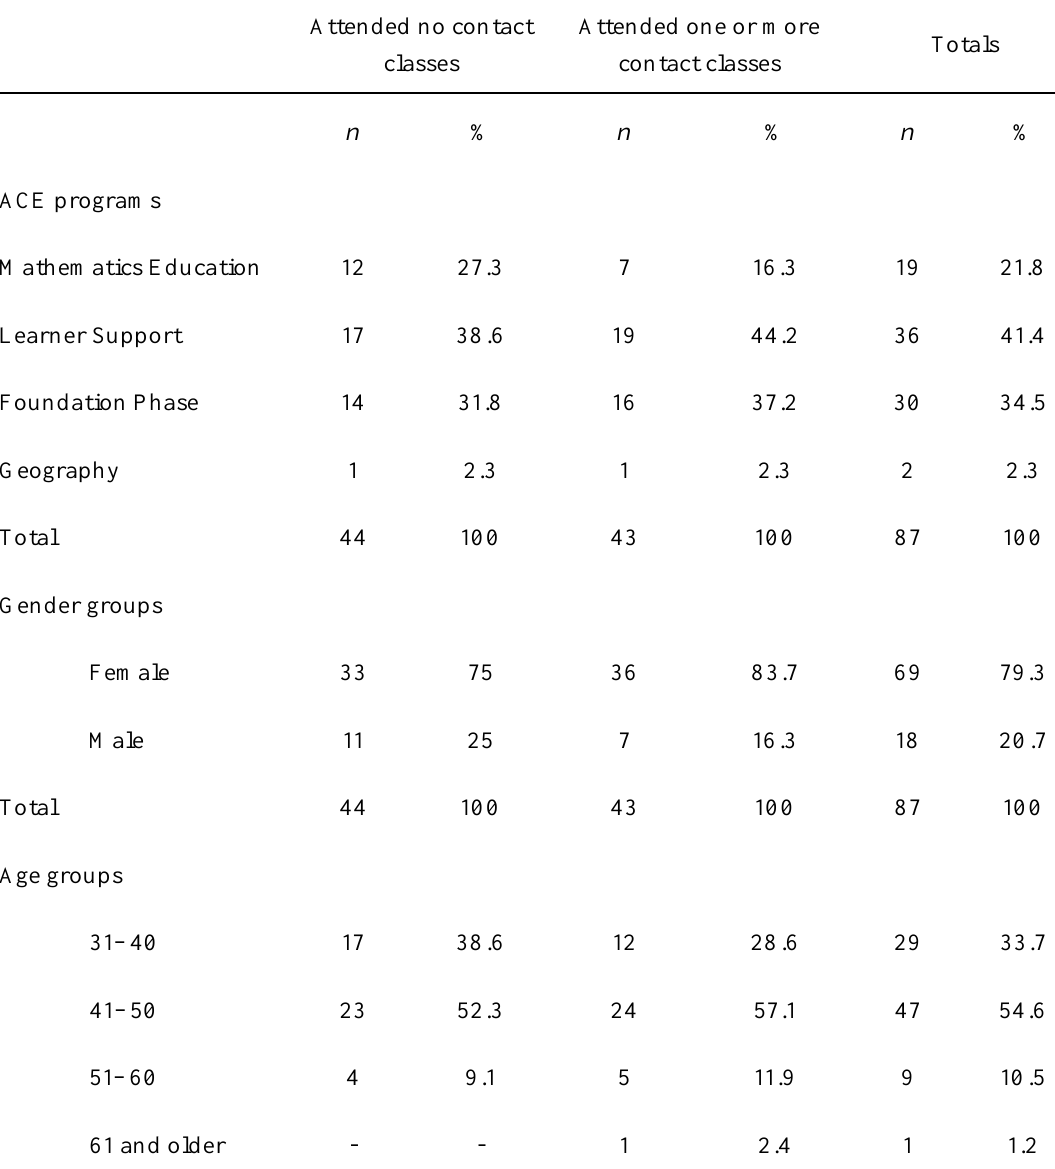
Demographical Information of the Quantitative Sample (N = 87) Attended no contact